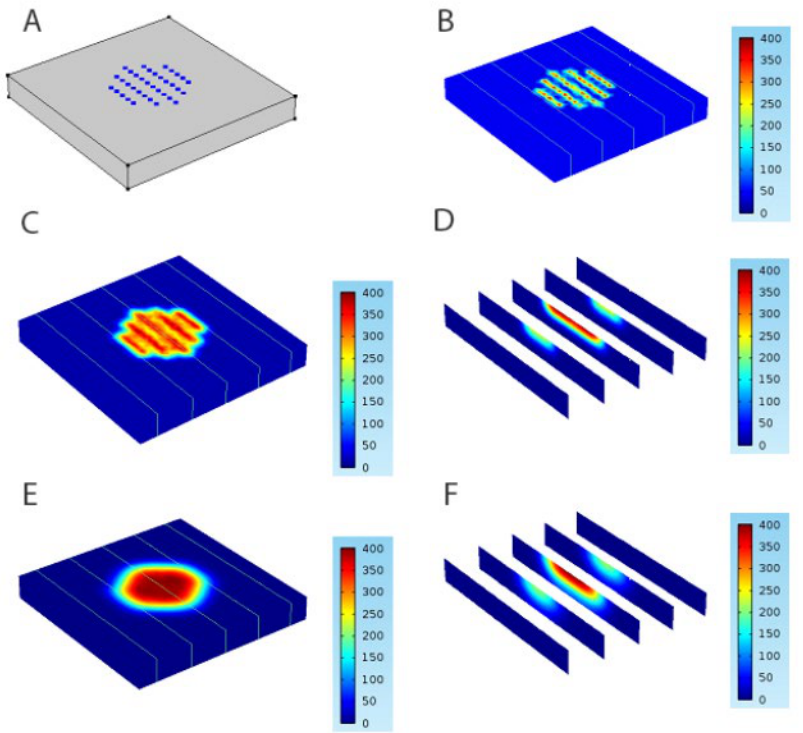
Figure 8. The FEA of drug diffusion in skin layers in ( A ) 0 h, ( B ) 2 h, ( C ) 12 h, ( D ) 24 h, ( E ) 2 days, and ( F ) 4 days after polymer microneedle insertion (Reprinted with permission from Ref. [111]. Copyright 2017, Elsevier).